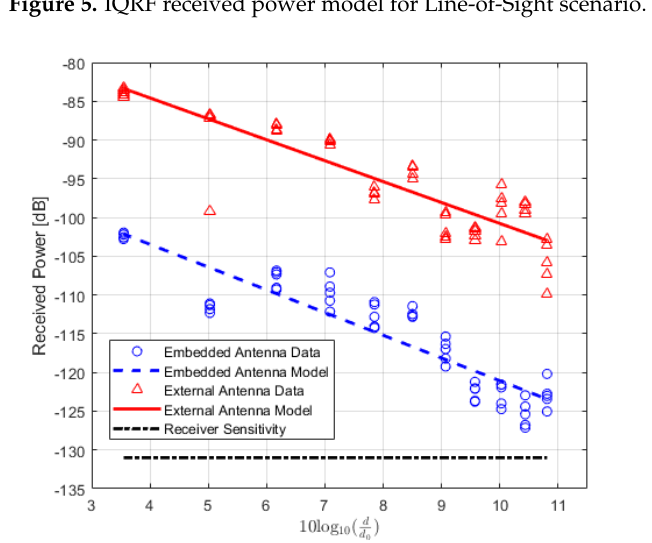
Figure 6. IQRF received power model for Non-Line-of-Sight scenario